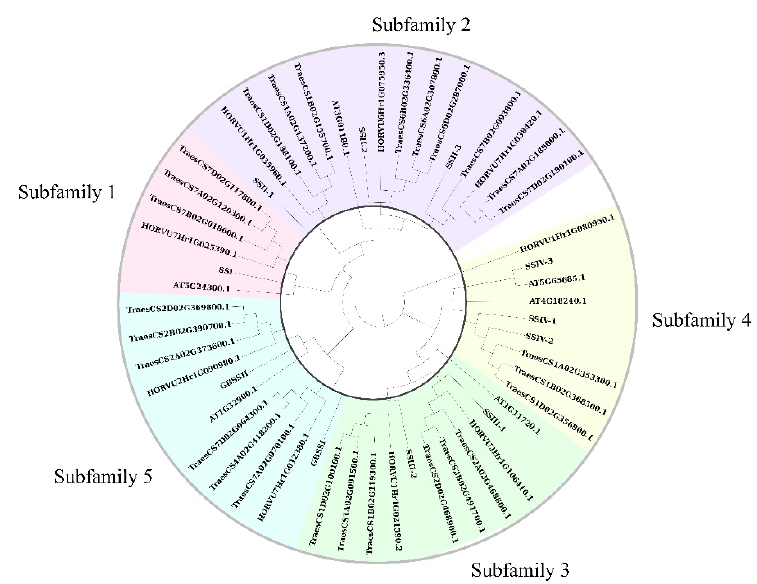
Figure 2. Phylogenetic tree of SSs between rice and other species.